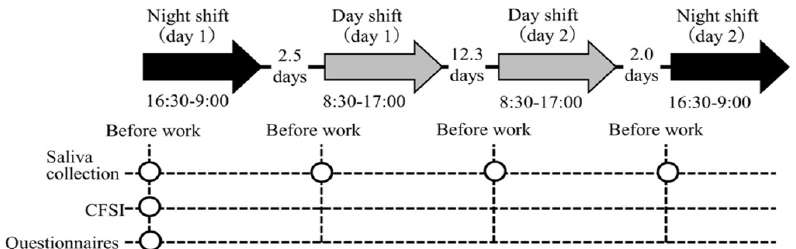
Figure 1. Illustration of the study procedure. Abbreviations: CFSI, Cumulative Fatigue Symptom Index. Note: The arrows indicate the shifts investigated. The intervals between each shift (average number of days) are indicated between arrows. The circles indicate each measurement point.